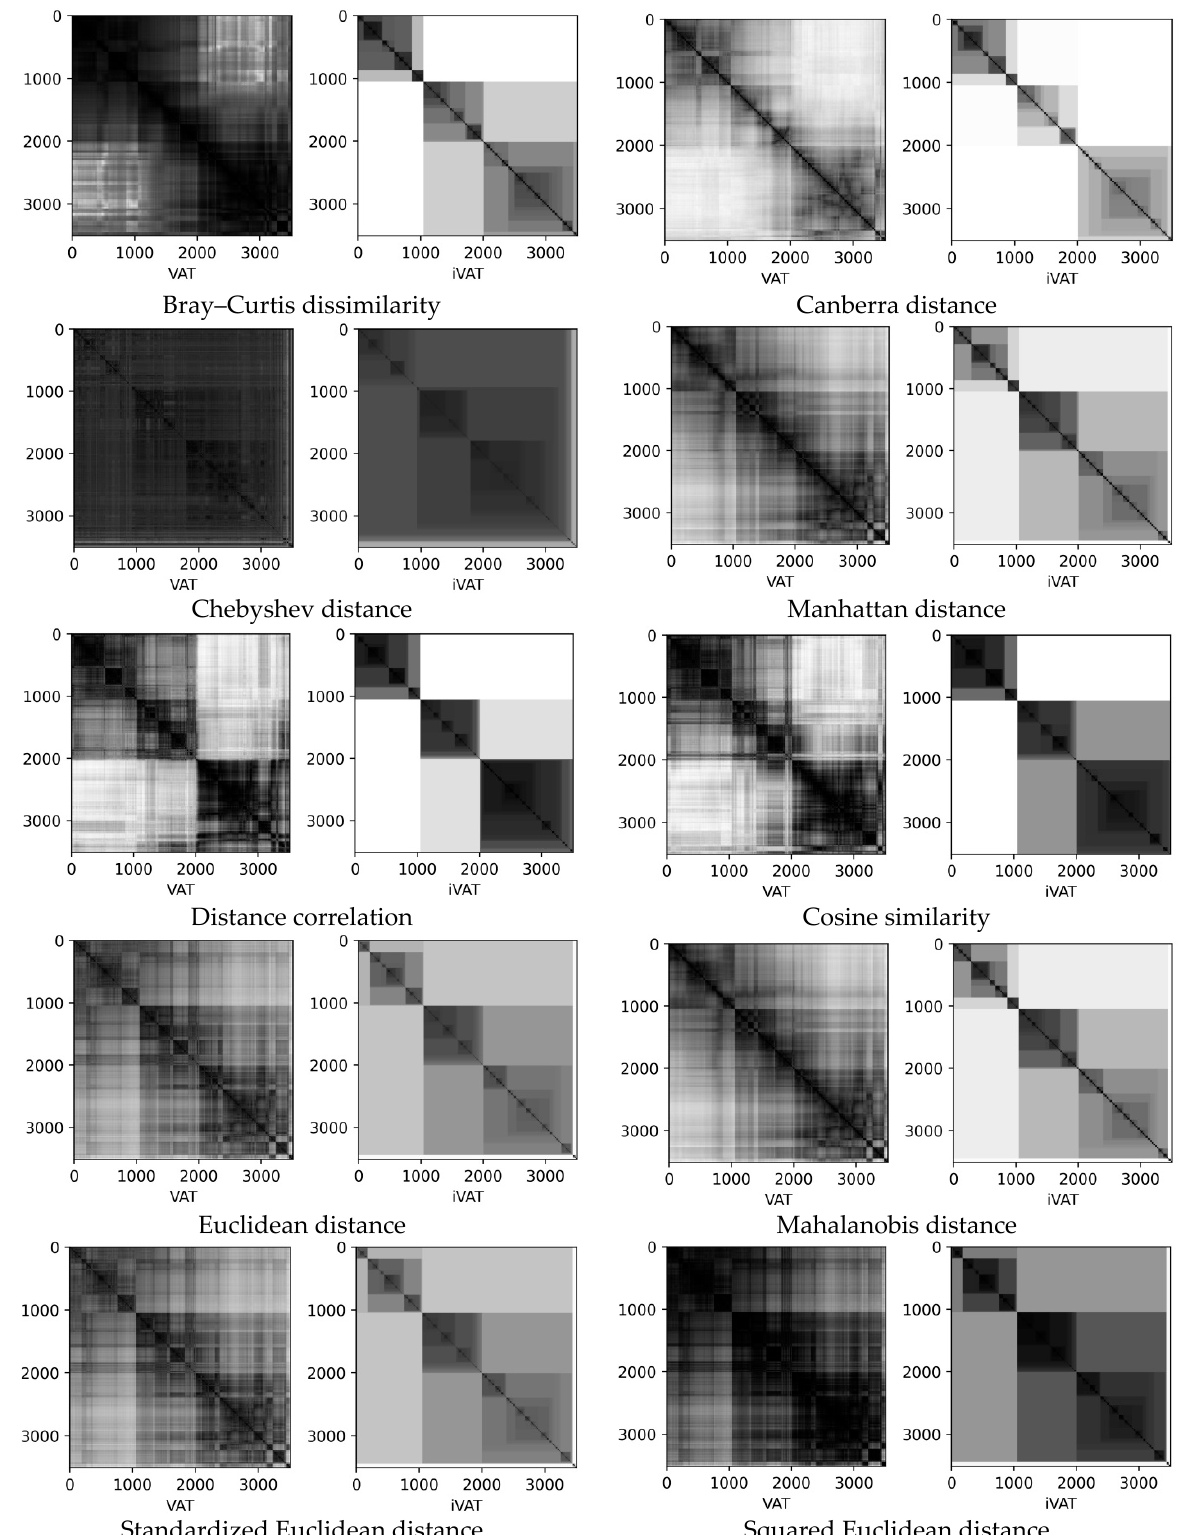
Figure A10. Lower Yenisei forestry. Cluster heat map.